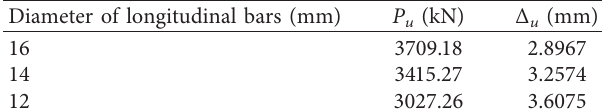
Table 3: Influence of diameter of longitudinal bars on ultimate axial bearing capacity and displacement of the specimen.